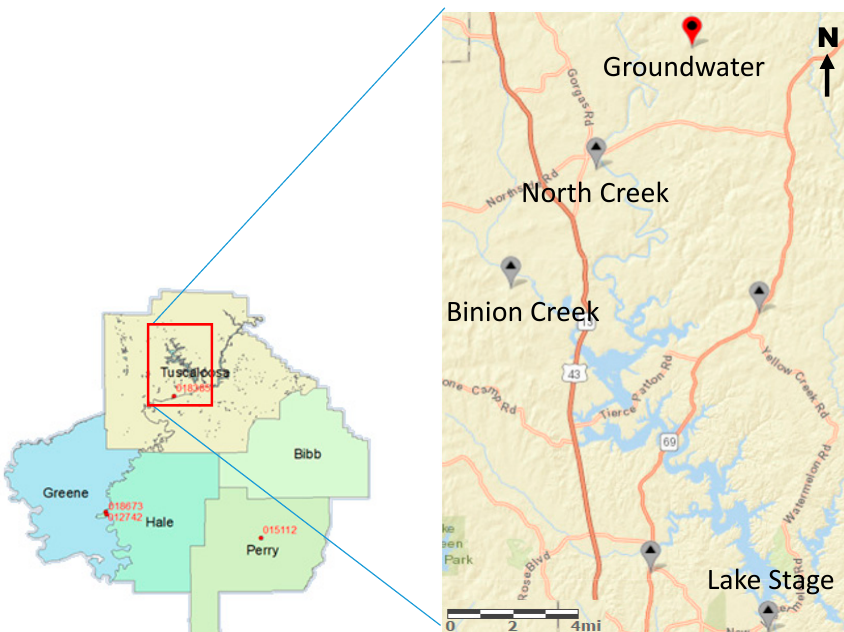
Figure 1. Left : The study area and surrounding counties, showing the precipitation stations as red dots with their National Oceanic and Atmospheric ID. Right : The study area with gray points denoting surface water stations and the red point showing the position of the groundwater well.